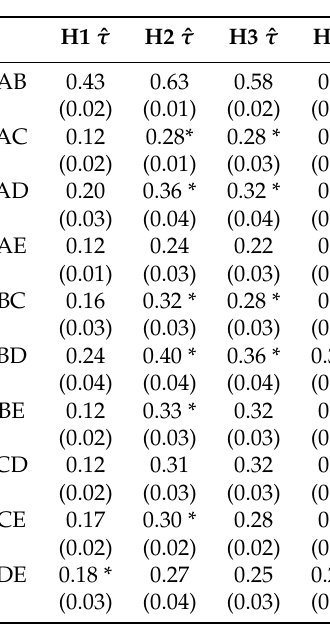
Figure 4. Autocorrelation function, histogram of posterior and trace plot for DE (Model H3). Table 4. Estimates of association conditioned to two failures (good matches indicated by